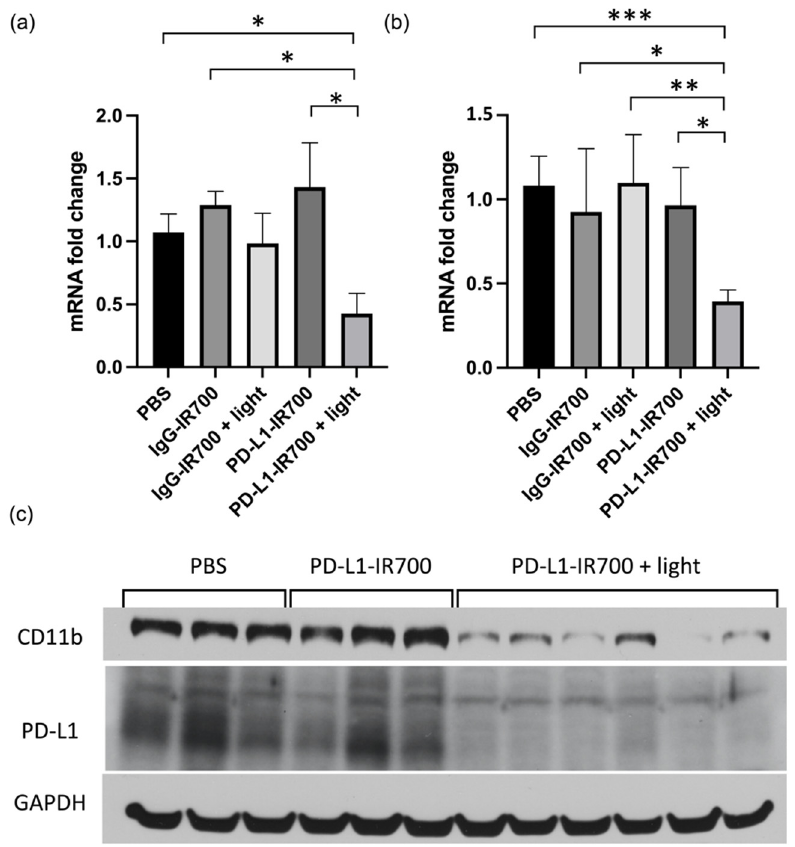
Figure 6. mRNA expression levels in orthotopic tumors 3 weeks post NIR-PIT for PD-L1 ( a ) and